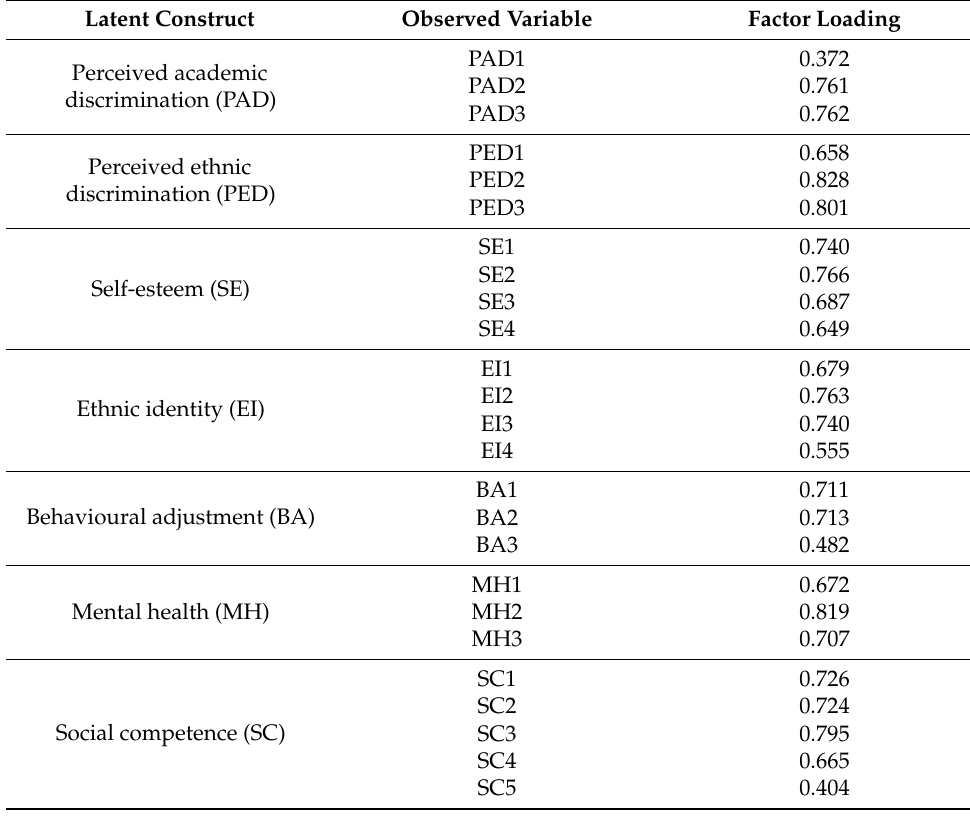
Table 3. Standardised factor loadings of observed variables on latent constructs.